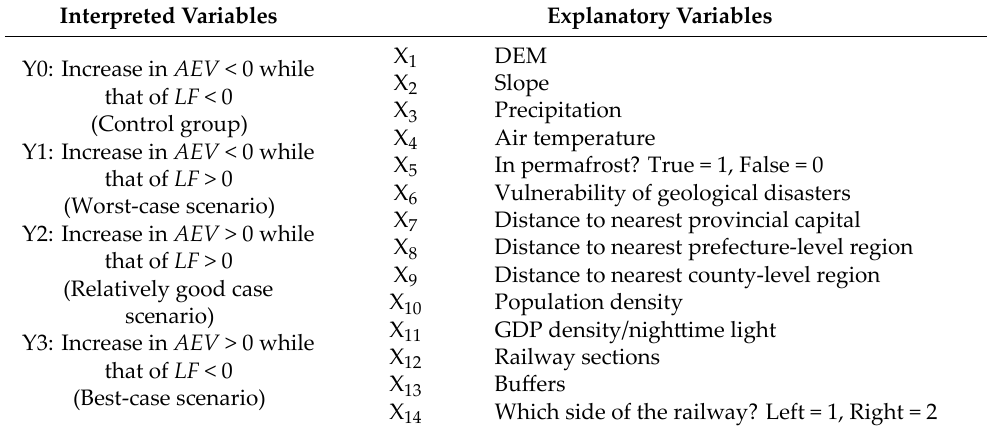
Table 2. Selection and interpretation of